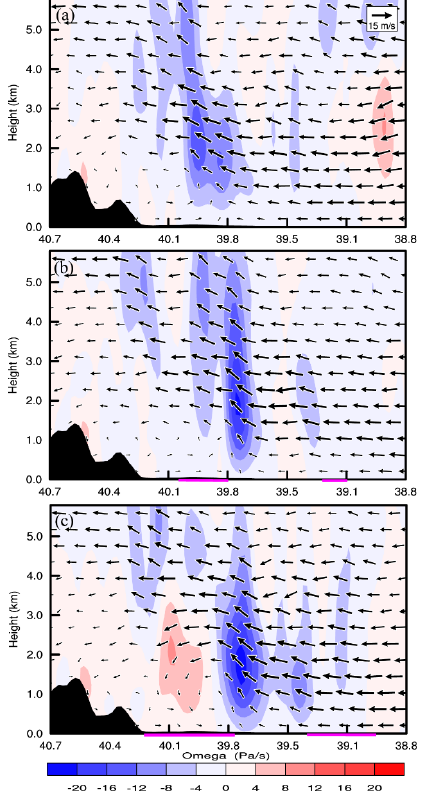
Figure 9. Cross section of vertical velocity (shading; units: Pa s −1 ) and wind vector along the blue line in Figure 2c on 06:00 UTC on 20 July 2016. ( a ) No urban test; ( b ) Urban06 test; ( c ) Urban16 test. The pink line shows the urban areas.